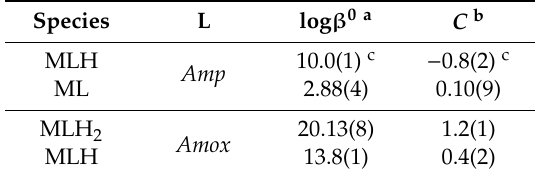
Table 3. Thermodynamic formation parameters for Mn 2 + - Amp and Mn 2 + - Amox species.